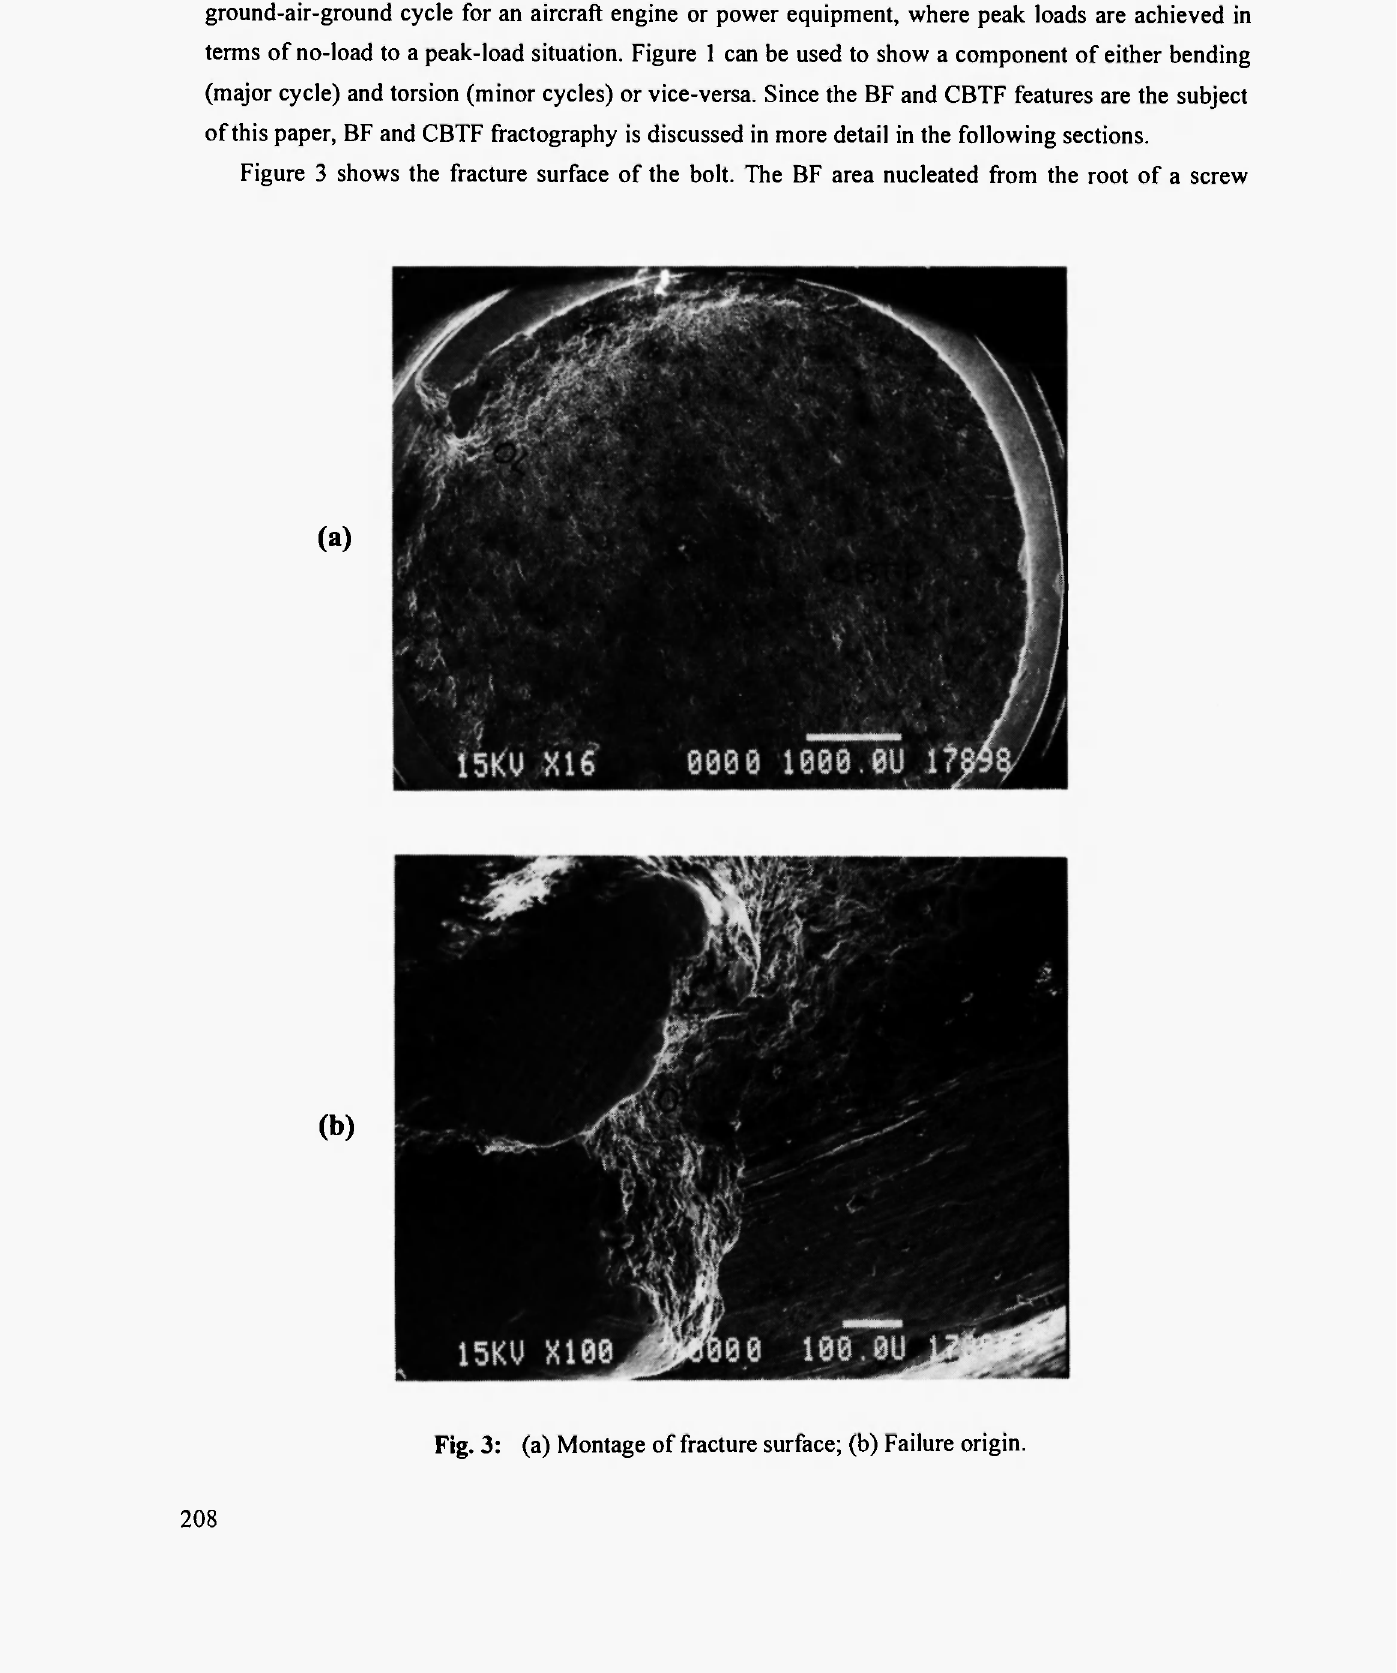
Fig. 3: (a) Montage of fracture surface; (b) Failure